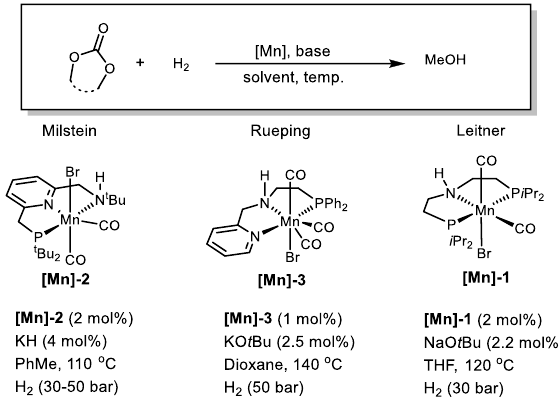
Figure 15. Manganese catalysts developed for hydrogenation of carbonates.